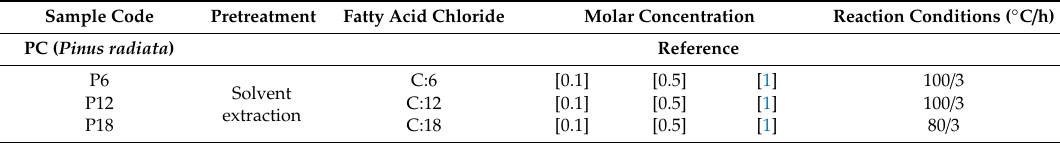
Table 1. Procedure and esterification